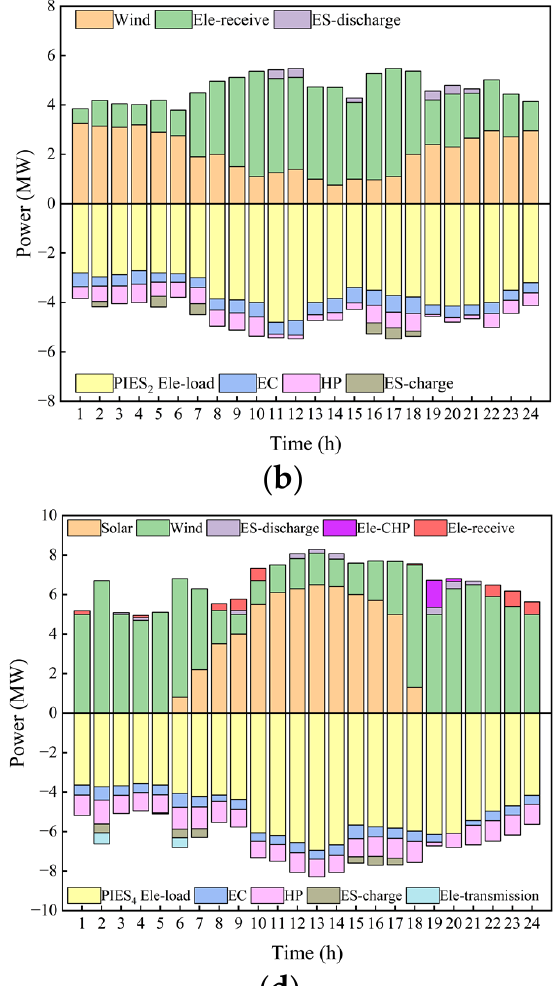
Figure 17. PIES 1 gas network for scenario 4. Table 2. Costs of a RIESG under different scenarios Cost/RMB